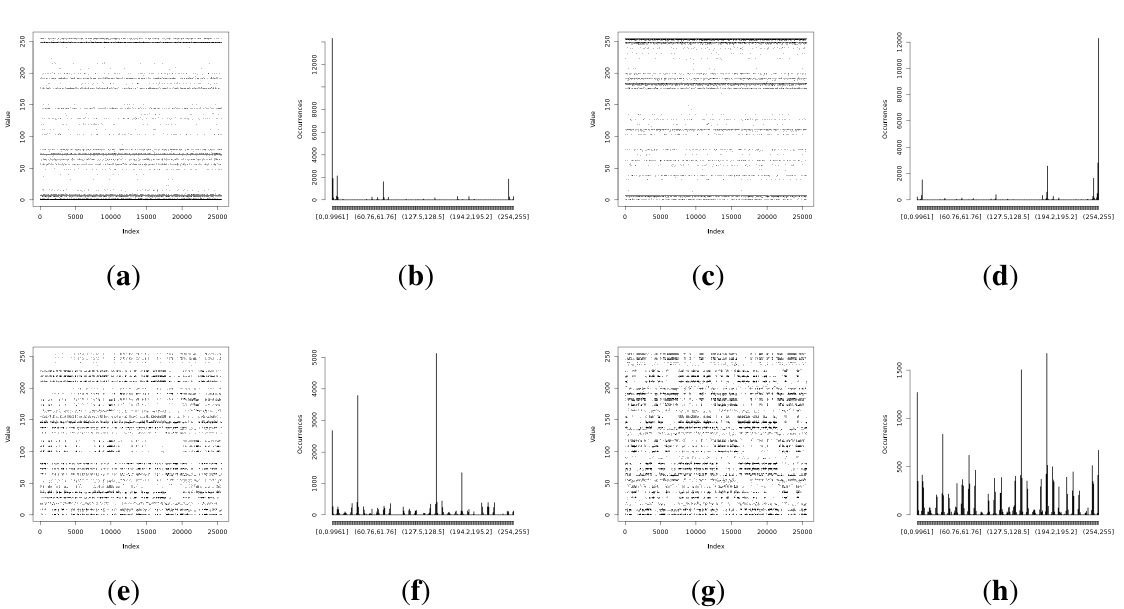
Figure 6. Initial experimental results of the harvested entropy by the third method in conjunction with the particular on-board sensor. ( a ) Light (1) sensor entropy; ( b ) distribution from the Light (1) sensor; ( c ) the Light (2) sensor entropy; ( d ) distribution from the Light (2) sensor; ( e ) humidity sensor entropy; ( f ) distribution from the humidity sensor; ( g ) temperature sensor entropy; ( h ) the distribution from the temperature sensor.